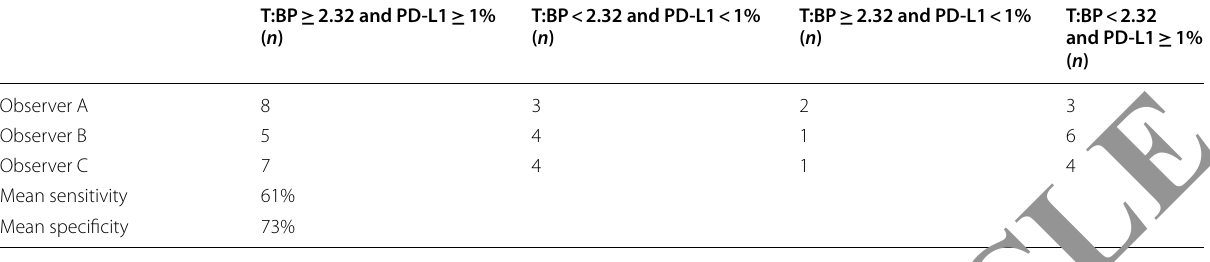
Table 3 Summary of PD-L1 assessments made by T:BP using SPECT/CT and 1% by IHC, along with interobserver mean sensitivity and specificity ≥